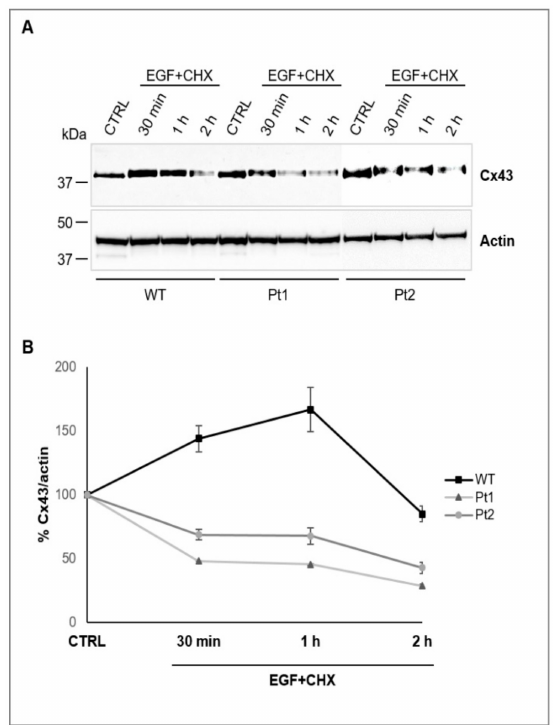
Figure 5. WT MLC1 increases Cx43 protein stability. ( A ) WB analysis of protein extracts (40 µ g) of U251 astrocytoma cells overexpressing MLC1 WT or carrying Pt1 and Pt2 pathological mutations, untreated (CTRL) or treated with EGF (200 ng / mL) in the presence of 100 µ g / mL of cycloheximide (CHX) for 30 min, 1 h and 2 h reveals di ff erences in Cx43 degradation kinetics among the cell lines analyzed. Cx43 protein levels decrease slower in WT MLC1-expressing cells when compared to the Pt1 and Pt2 mutant cell lines particularly after 30 min and 1 h of EGF / CHX treatment. Actin is used as a loading control. Molecular weight markers are indicated on the left (kDa). One representative experiment out of three performed is shown. ( B ) Densitometric analysis of Cx43 protein bands normalized with actin protein levels in the same samples: Data are expressed as a percentage of the value measured in control untreated cells (100%). Means ± SEM of three experiments are